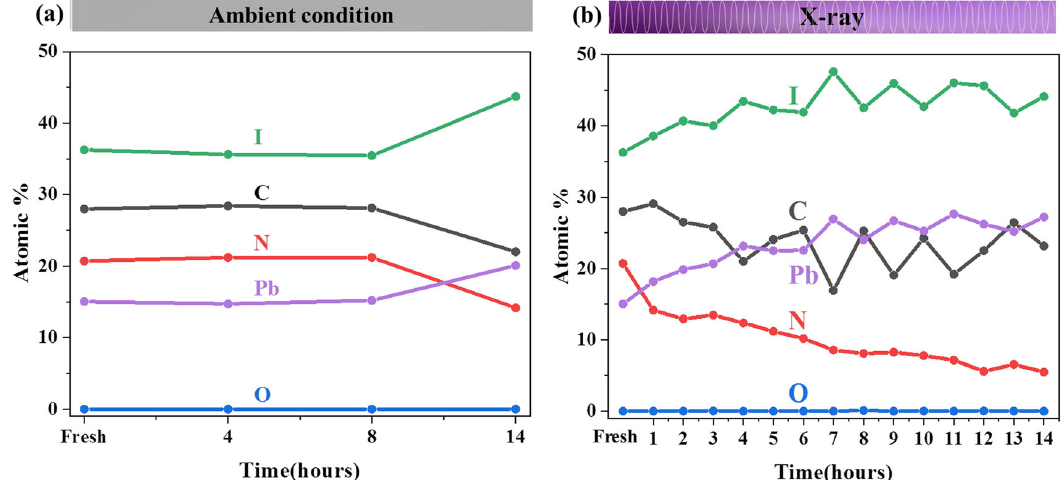
Fig. 4 Surface elemental ratio of MAPbI 3 under dark and X-ray. a Surface composition of CH 3 NH 3 PbI 3 perovskite under ambient and b X-ray irradiation conditions over time in ultrahigh